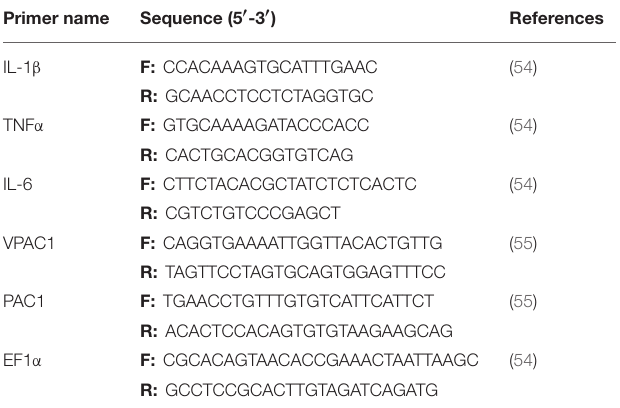
TABLE 1 | Primers used for qRT-PCR analysis of RTS11.